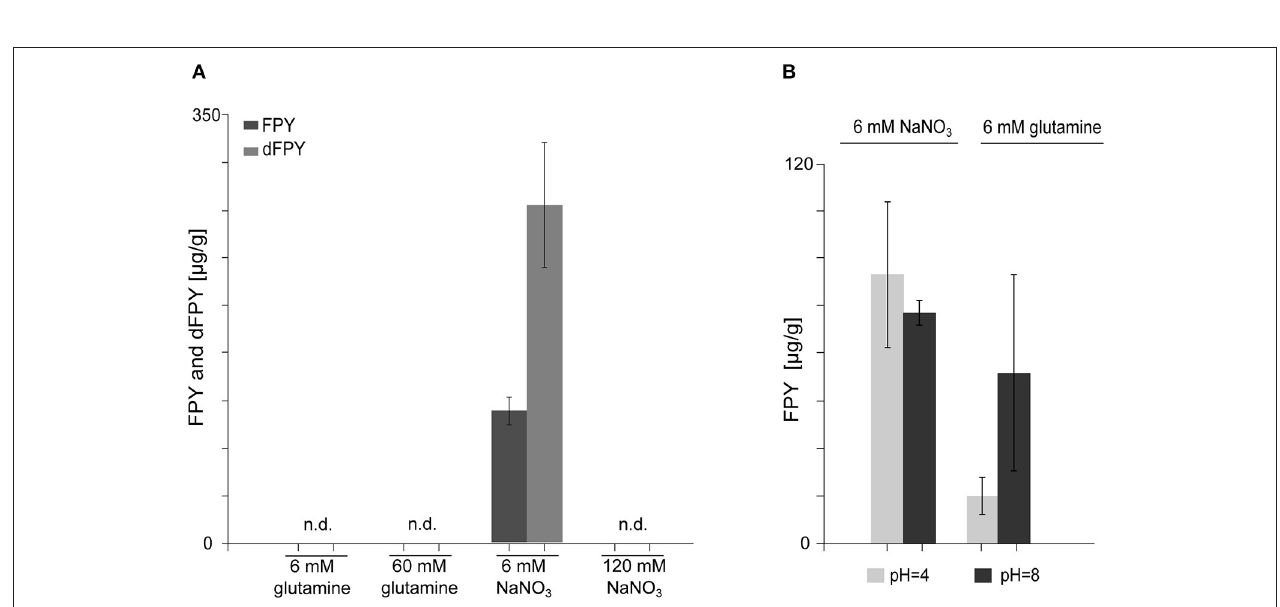
FIGURE 4 | Biosynthesis of fusapyrone (FPY) and deoxyfusapyrone (dFPY) is N-repressed but independent of the ambient pH in F. mangiferae . (A) Measurement of FPY and dFPY levels with HPLC-HRMS. Production of FPY by FmWT under standard laboratory culture conditions i.e., liquid ICI supplemented with 6mM or 60mM glutamine and 6mM or 120mM NaNO 3 for 7 days at 30 ◦ C. FPY and dFPY are only produced in detectable amounts by FmWT in media supplemented with 6mM NaNO 3 . Experiments were performed in triplicates. Mean values and standard deviations are shown in diagram. n.d., not detected in the supernatant. (B) Quantitative determination of FPY production levels by FmWT measured with HPLC-HRMS. FmWT was cultivated in 6mM NaNO 3 and 6mM glutamine for 7 days at 30 ◦ C in the dark. The pH was set prior inoculation to respective levels using 100mM NaH 2 PO 4 (pH 4) and 100mM Na 2 HPO 4 (pH 8). pH levels were controlled after 7 days using pH paper. Experiments were performed in triplicates. Mean values and standard deviations are shown in diagram.